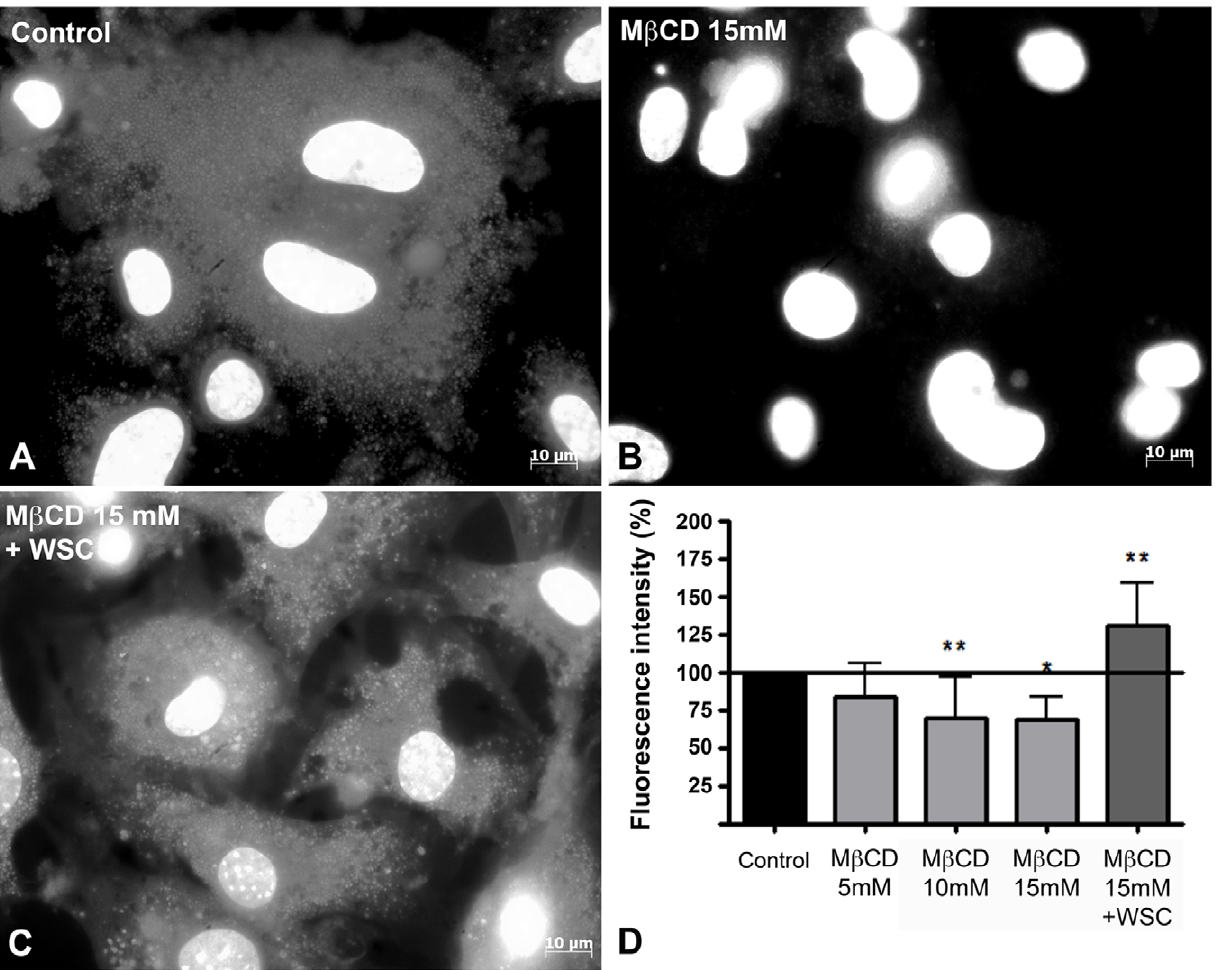
Figure 1. M b CD treatment is effective in sequestering cholesterol from the plasma membrane. (A) Control, (B) 15 mM M b CD treated and (C) 15 mM M b CD followed by 0.05 mM WSC treated cardiomyocytes show significant changes in Filipin labeling. Cholesterol-depleted cells (B) reveal very little Filipin labeling, whereas cholesterol-replenished cells show strong labeling for cholesterol, similar to control cells. (D) Cardiomyocytes treated with 5, 10 or 15 mM of M b CD reveal a substantial decrease in Filipin labeling in a dose-dependent manner whereas cholesterol replenishment with 0.05 mM of WSC returns Filipin fluorescence to control values. Normalized data are shown as mean of triplicates 6 SD. Asteriks indicate statistically significant differences (* p , 0.05 and ** p , 0.01, One way ANOVA followed by Newman-Keuls) between control and treated cells. Scale bar: 10 m m.